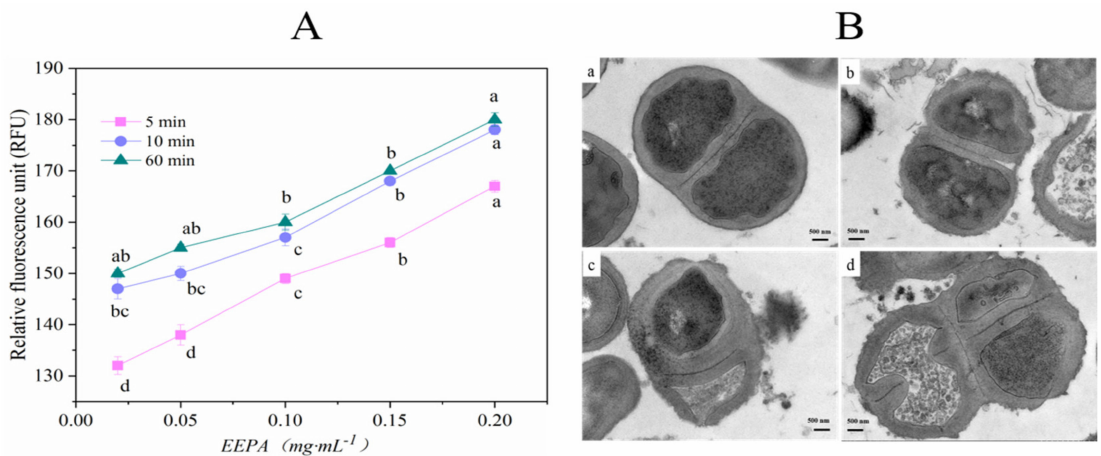
Figure 5. The bactericidal mechanism analysis of EEPA against S. aureus . ( A ) Membrane permeability analysis. These experiments were performed in triplicate. Values with different letters as the label are significantly different for different concentrations ( p < 0.05). ( B ) TEM images of S. aureus cells: (a) control; (b–d) treated with MIC of EEPA and S. aureus